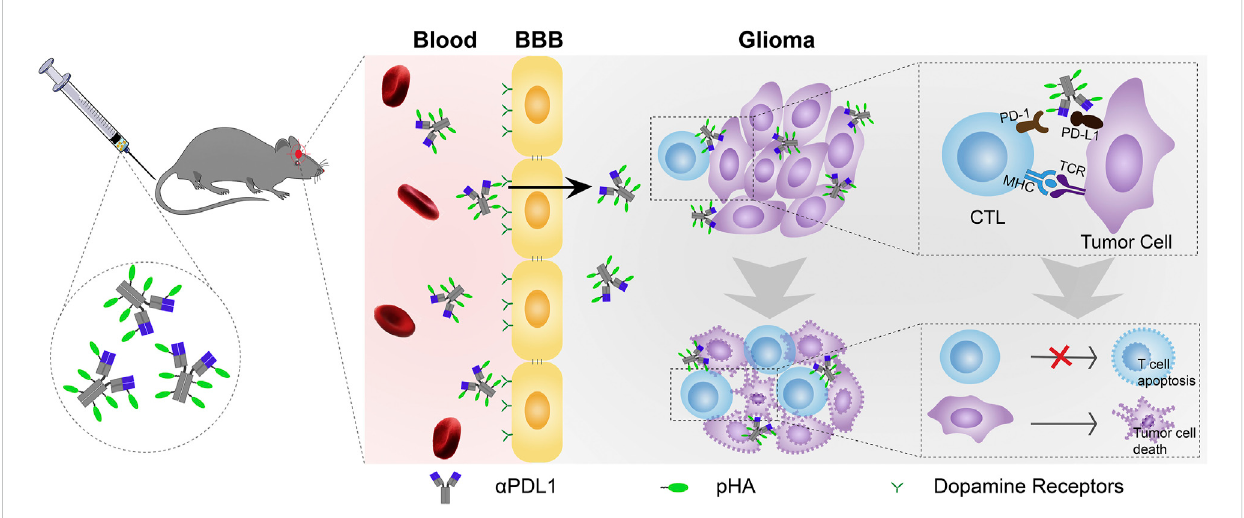
FIGURE 7 Schematic of p-hydroxybenzoic acid modi fi cation for antibody delivery crossing the BBB to treat glioma (Guo et al., 2020). Copyright © 2020,